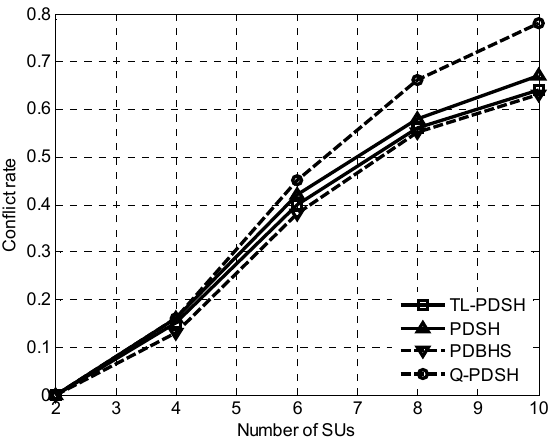
Figure 2. Conflict rate versus number of SUs.